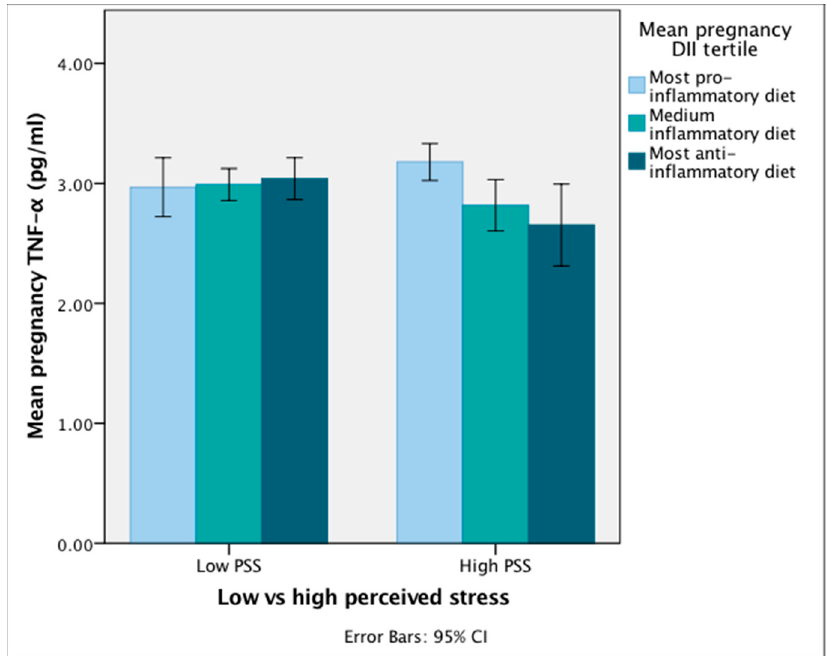
Figure 4. Mean pregnancy TNF- α levels among pregnant women with high and low perceived stress scores, according to DII tertile. CI: Confidence Interval. Caption: DII, dietary inflammatory index; PSS, perceived stress score; TNF, tumor necrosis factor. Although DII, PSS, and TNF- α were entered to regression models as continuous variables, for the purpose of graphically depicting the effect of the DII*PSS interaction term on TNF- α , mean pregnancy DII was divided into tertiles and mean pregnancy PSS was dichotomized by the median value. A pro-inflammatory diet influences higher TNF- α levels only among women reporting higher perceived stress scores across pregnancy. Women who report lower perceived stress levels do not experience any difference in TNF- α levels, regardless of the inflammatory potential of their diet.